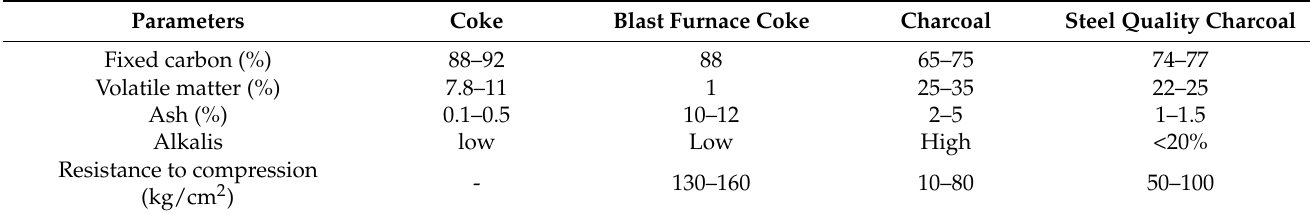
Table 2. Quality criteria for biochar and coke intended for the steel industry